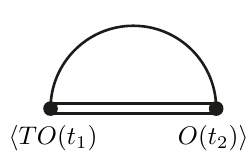
Figure 2 . Vacuum bubble contribution to the persistence